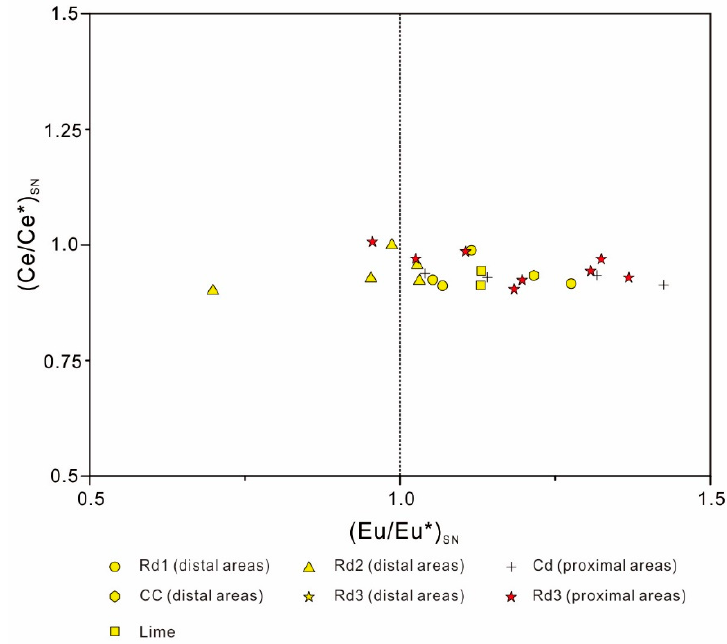
Figure 17. Cross-plot of Eu/Eu* and Ce/Ce* of limestone and dolomite shows Ce anomalies and Eu anomalies.